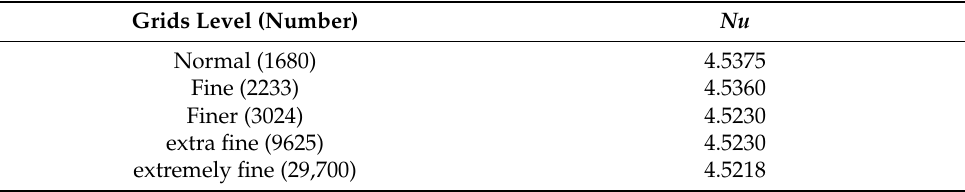
Table 2. Comparison of average Nusselt numbers for different grids at Ra = 10 5